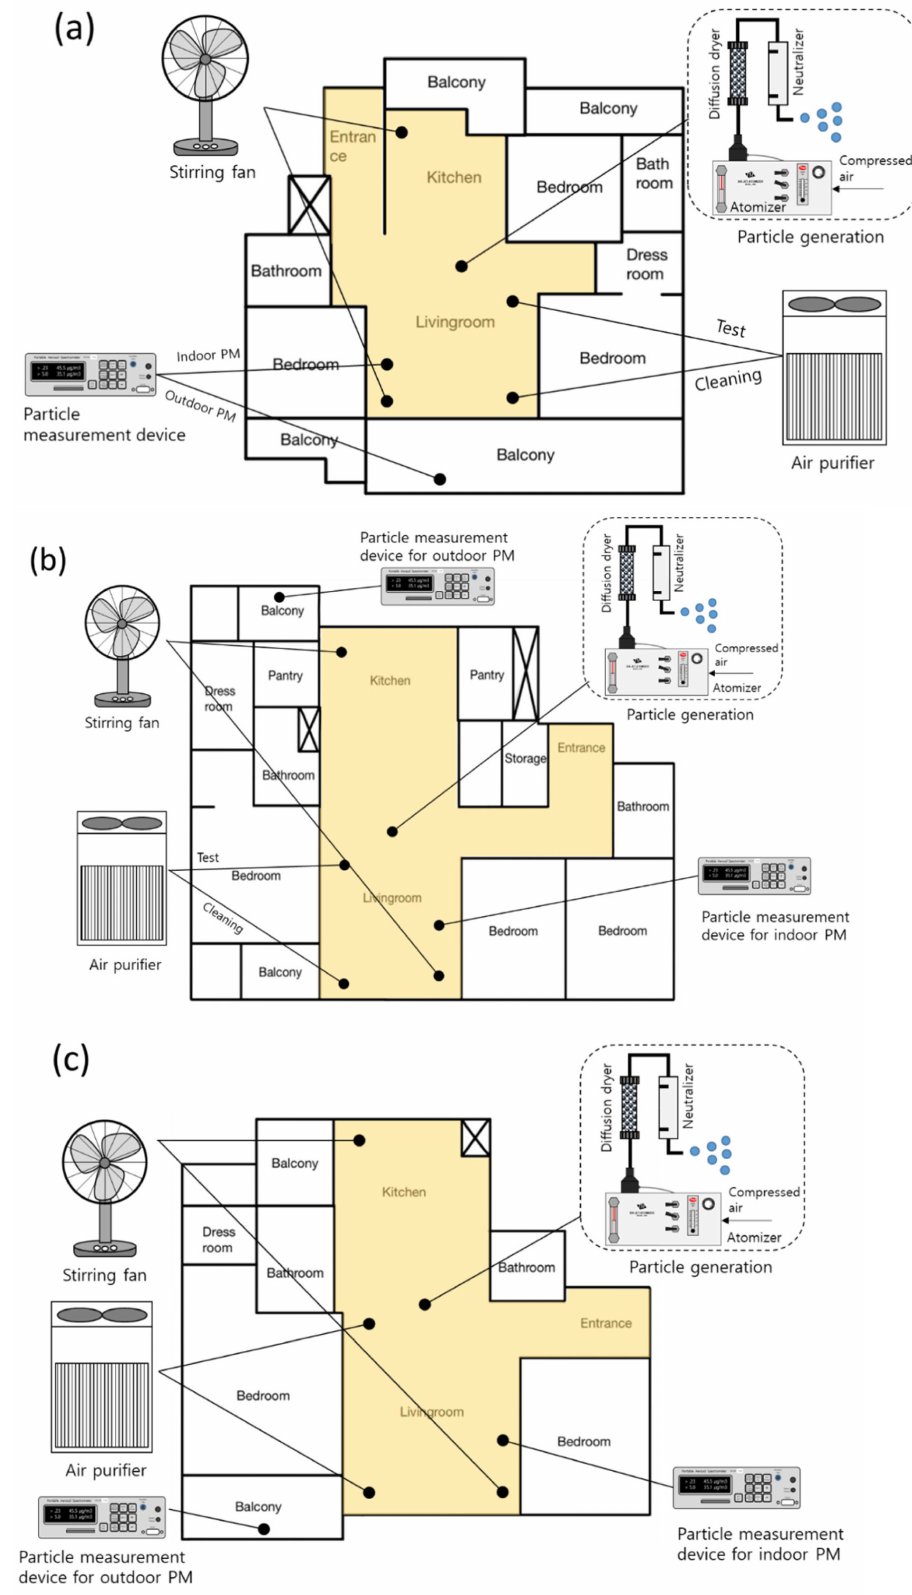
Figure 2. Floor plan of three test houses (( a ) A house, ( b ) B house, and ( c ) C house) and the layout of experimental devices. A yellow colored space of a living room with an entrance and a kitchen is confined as a test volume in this